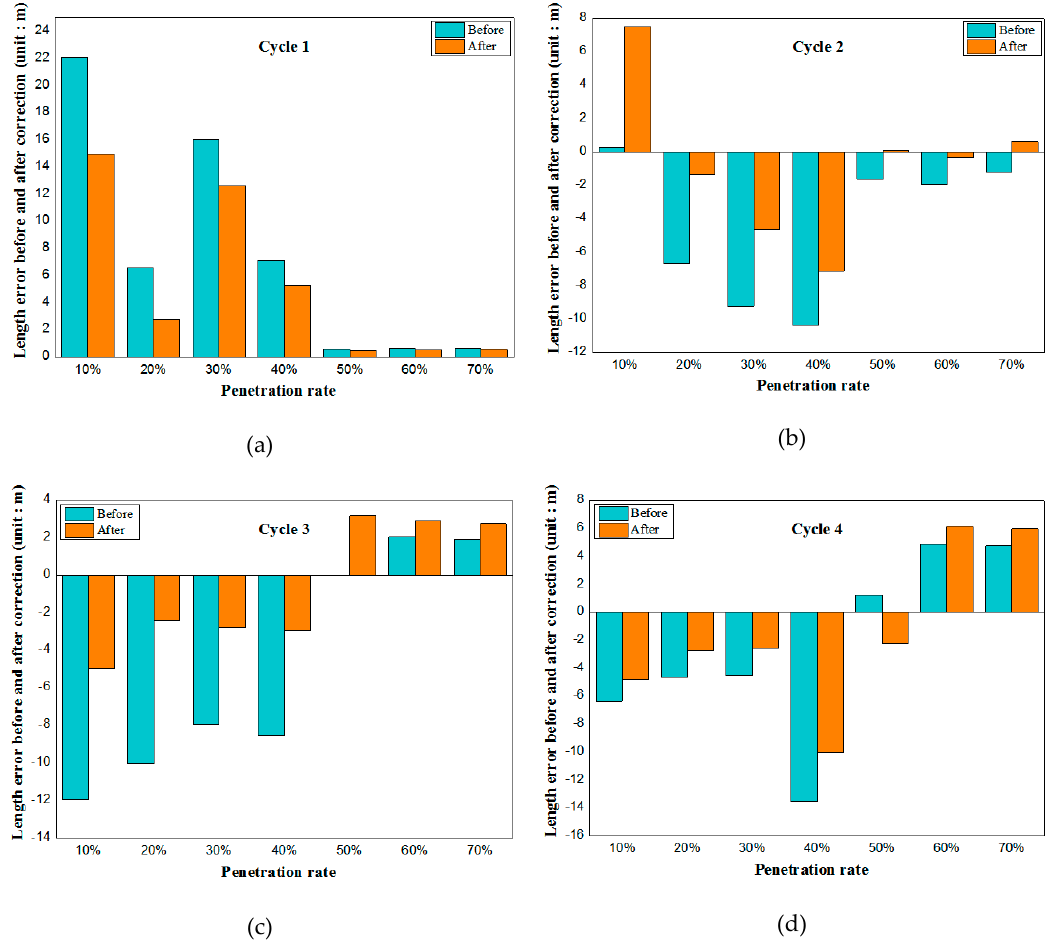
Figure 7. Queue length error before and after correction in cycle 1 ( a ) and queue length error before Figure 7. Q ueue length error before and after correction in cycle 1 (a) and q ueue length error before and after correction in cycle 2 ( b ) and queue length error before and after correction in cycle 3 ( c ) and and after correction in cycle 2 (b) and q ueue length error before and after correction in cycle 3 (c) and queue length error before and after correction in cycle 4 ( d q ueue length error before and after correction in cycle 4 (d) .